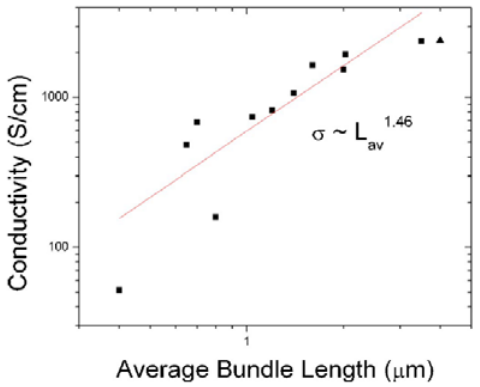
Figure 3. Variation of the CNT network electrical conductivity with the average bundle length of the CNTs in the network. The relationship between the conductivity of the CNT network and the average bundle length is σ ~ L av1.46 . Reprinted with permission from [62], Copyright (2006) by the American Institute of